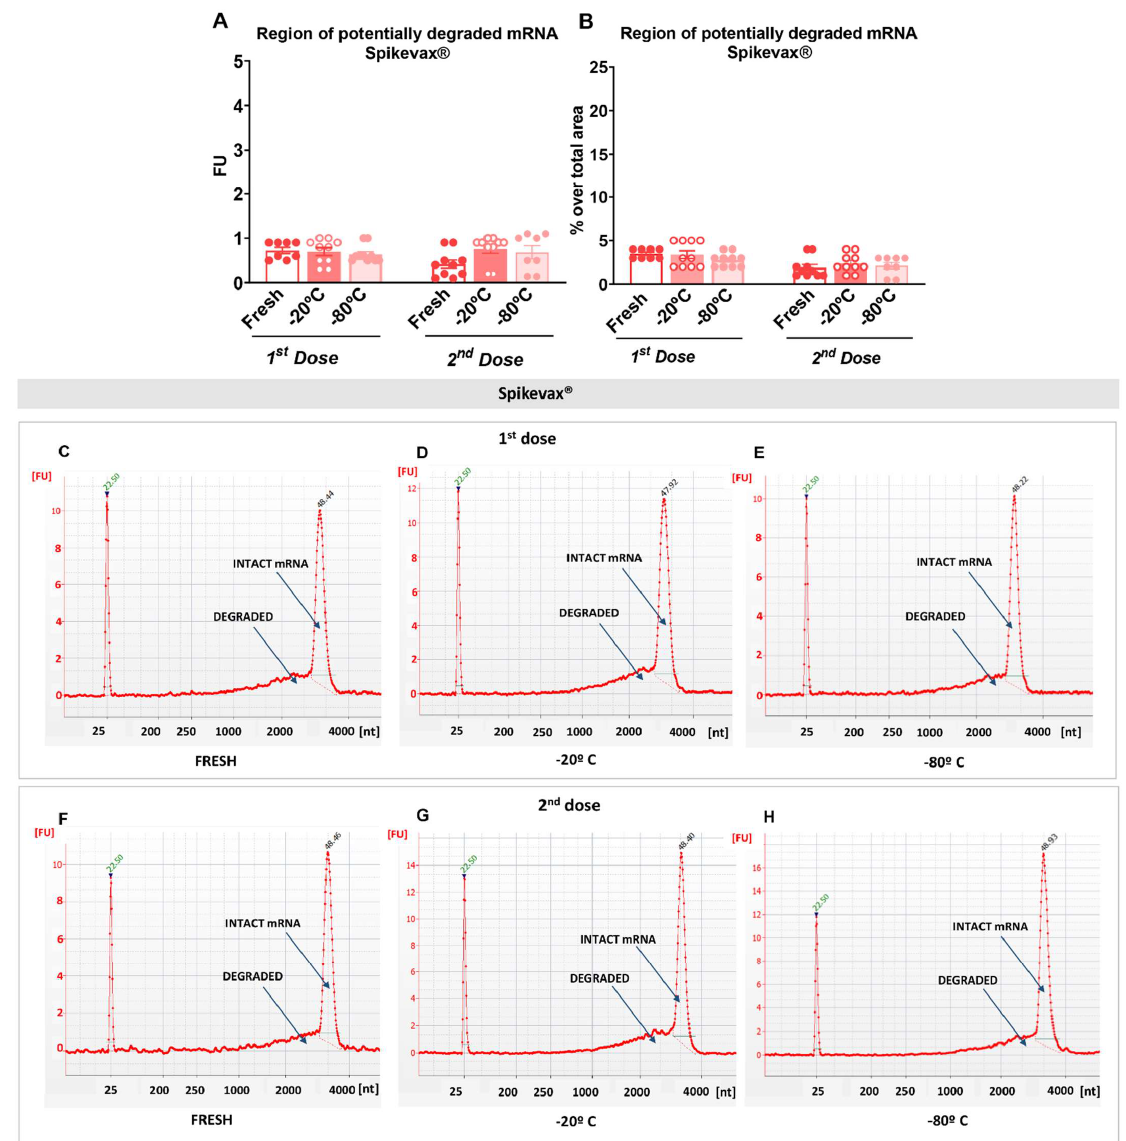
Figure 4. Different handling and re-freezing conditions did not affect mRNA integrity of reconsti- tuted Spikevax ® COVID 19 vaccines. ( A ) Measurement of the region of potentially degraded mRNA in fluorescence units (FUs) of the regularly used (fresh) samples or under −20 °C or −80 °C storage conditions in the first and second doses. Individual values of FU with the mean ± SEM are repre- sented. ( B ) Percentage over the region’s total area of potentially degraded mRNA of the samples regularly used (fresh), or under −20 °C or −80 °C storage conditions in the first and second doses. Individual values of FU percentage with the mean ± SEM are represented ( n = 10 per group). ( C – H ) Representative electropherograms expressed in FU of RNA integrity for different mRNA samples detailing the regions that indicate potentially degraded and intact with mRNA peaks in the regu- larly used (fresh) samples or under −20 °C or −80 °C storage conditions in the first and second doses. Statistical details are included in Table S1.